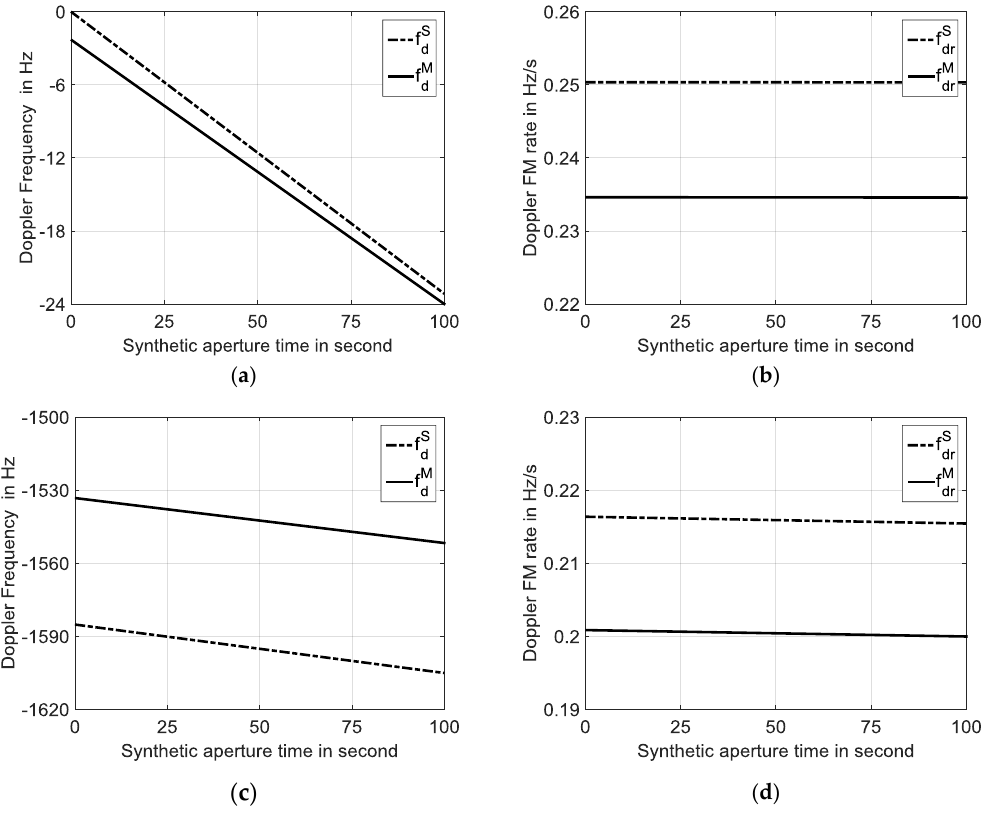
Figure 6. Comparison between the Doppler parameters of stationary Moon-Based SAR (superscript S) and motional Moon-Based SAR (superscript M) with a small visible range in azimuth and a m − a g 0 = 0: ( a ) Doppler frequency; ( b ) Doppler frequency modulation (FM) rate; with a large visible range in azimuth a g 0 − a m = π /6; ( c ) Doppler frequency; ( d ) Doppler FM rate.